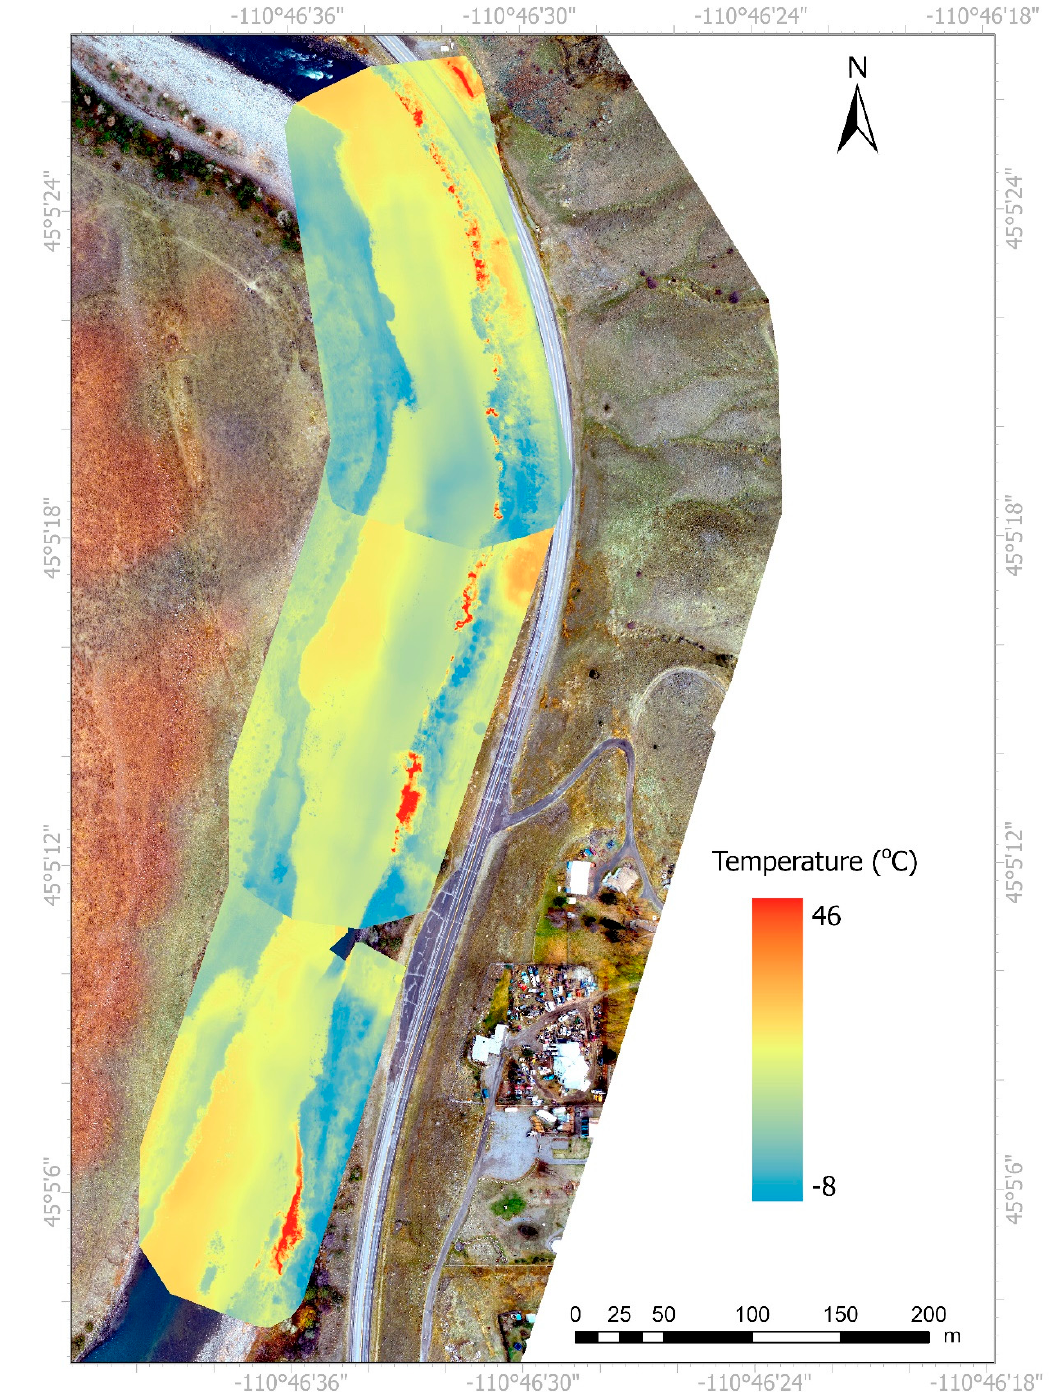
Figure A2. Thermal orthomosaics using transformed thermal data generated in Pix4D Mapper and Georeferenced in ArcPro for November. RGB orthomosaic corresponds to the flight data from March 2019.